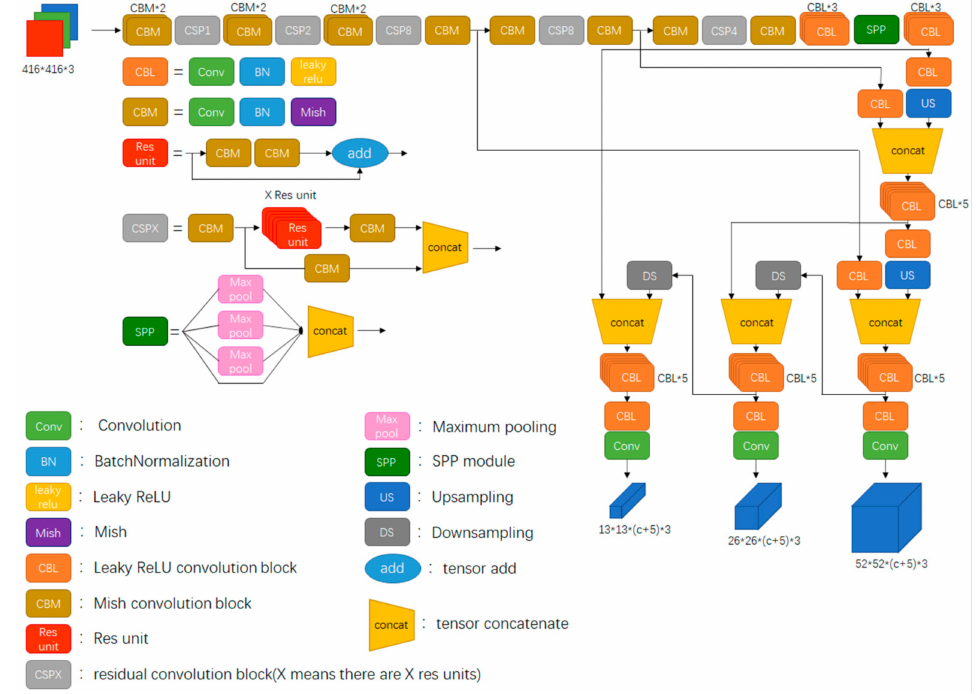
Figure 2. Structure of